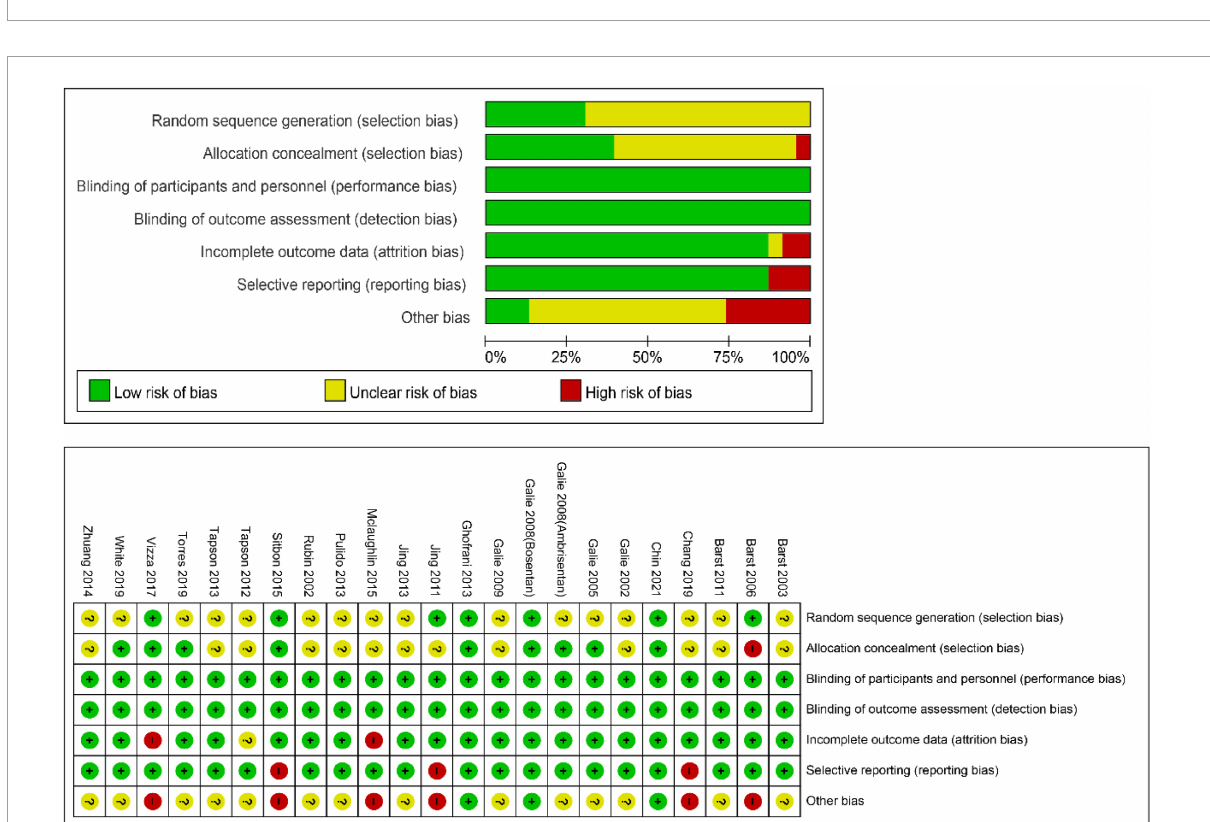
FIGURE6 Cochrane collaboration’s risk-of-bias tool and risk of bias graph for the pooled studies in this